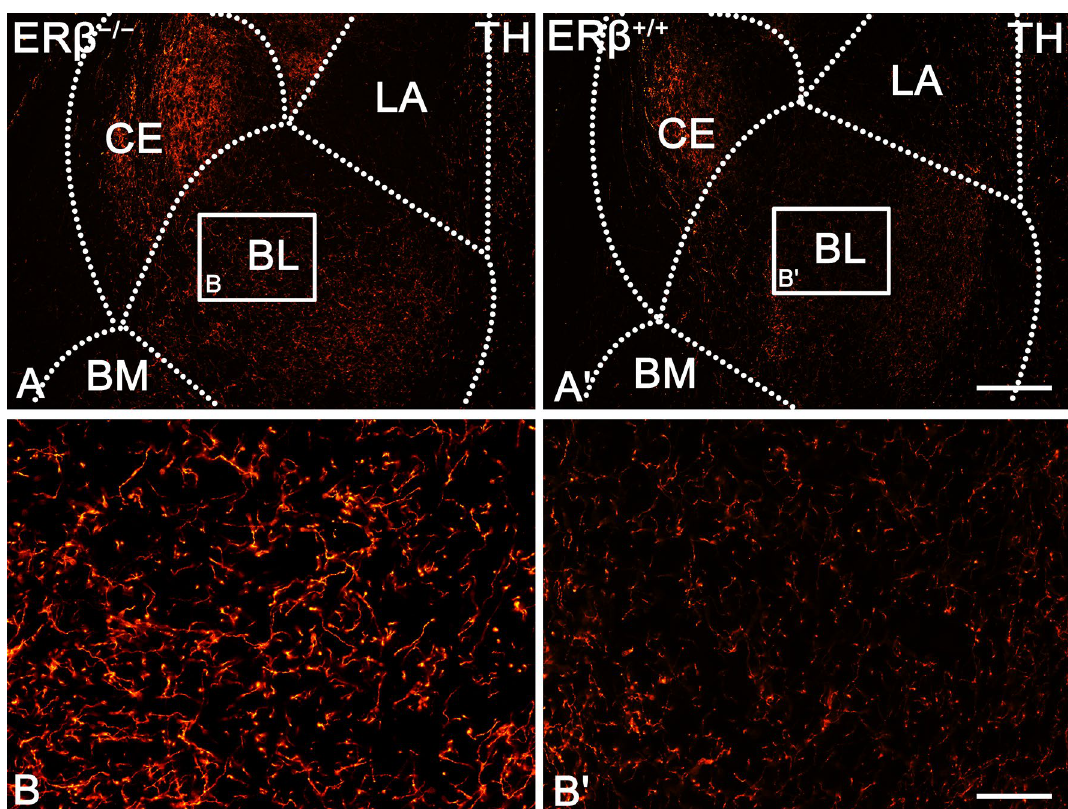
Figure 2. Representative colour photomicrographs illustrating the staining pattern of tyrosine hydroxylase (TH) in the amygdala of ERβ knock-out (ERβ −/− ) and wild-type (ERβ +/+ ) mice, n = 6 per group. ( A , B ) ERβ −/− mice. ( A ′ , B ′ ) ERβ +/+ mice. Note increased density and signal intensity of TH in ERβ −/− mice ( A , B ) when compared to ERβ +/+ littermates ( A ′ , B ′ ). LA—lateral nucleus, BL—basolateral nucleus, BM—basomedial nucleus and CE—central nucleus. The scale bar applies to all microphotographs, and it corresponds to the length of 200 µm in ( A , A ′ ), and 50 µm in ( B , B ′